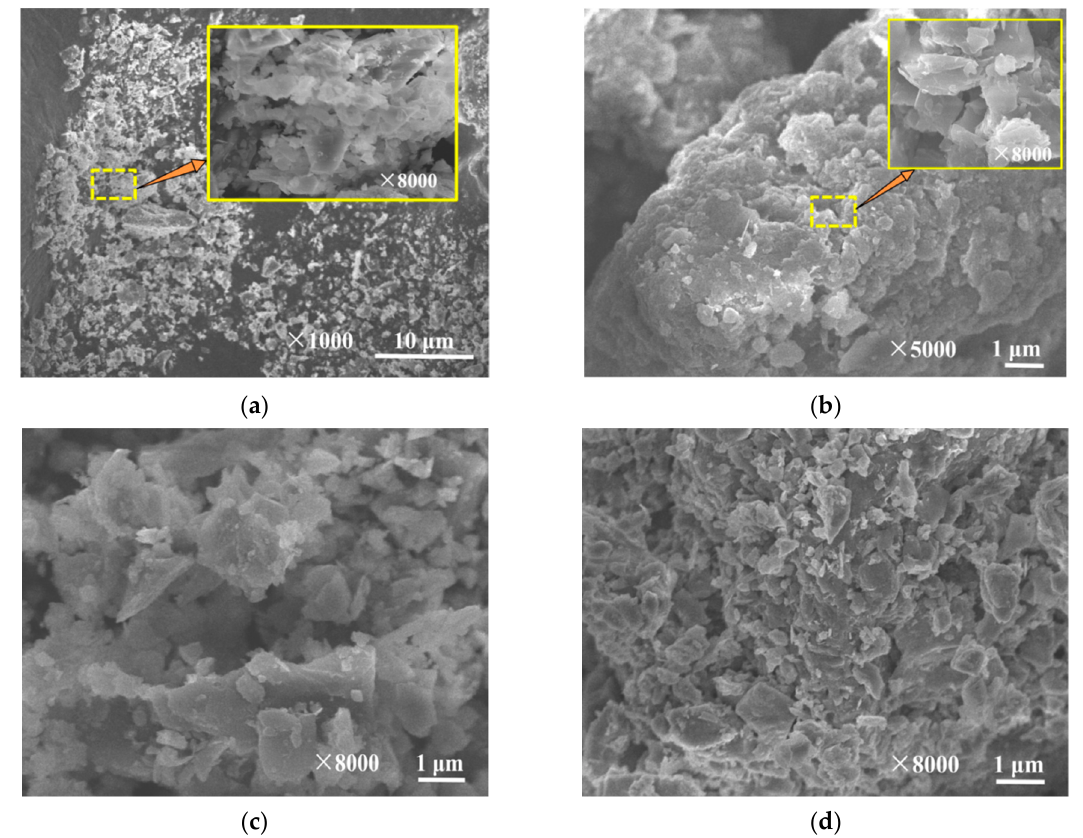
Figure 10. SEM images of IHA/TM before and after adsorption of Fe 2+ and Mn 2+ : ( a ) TM; ( b ) IHA; ( c ) IHA/TM; ( d ) IHA/TM after adsorption of Fe 2+ and Mn 2+ .